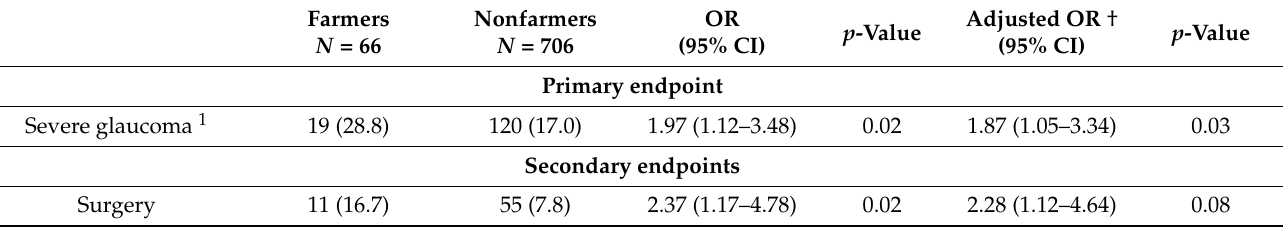
Table 2. Primary and secondary endpoints according to the agricultural